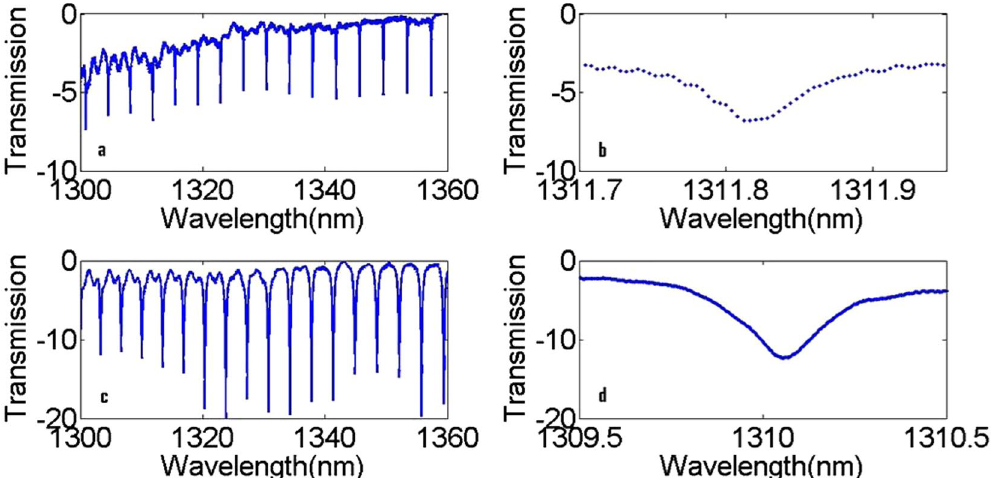
Figure 6. ( a ) Measured transmission spectrum at 1310 nm for a ring resonator with R = 20 µ m and G = 150 nm for the quasi – TE mode of 300 nm × 600 nm waveguide. ( b ) Spectrum of a single resonance. ( c ) Measured transmission spectrum at 1310 nm for a ring resonator with R = 20 µ m and G = 150 nm for the quasi – TM mode. ( d ) Spectrum of a single resonance.